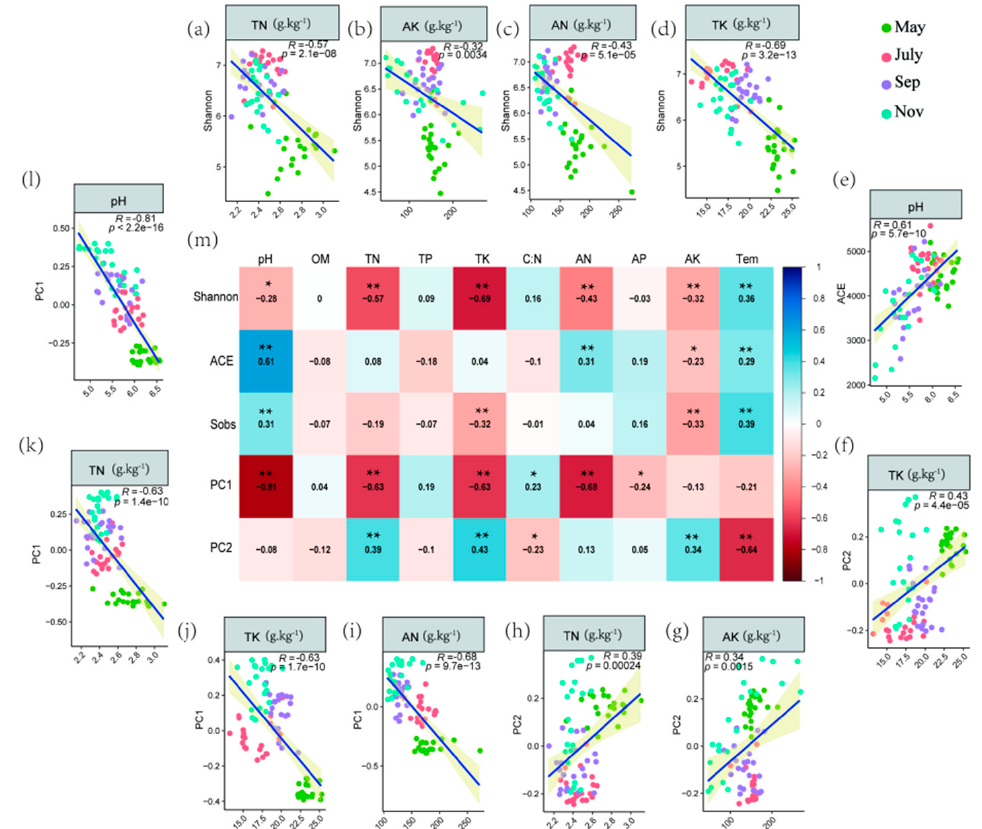
Figure 3. ( a – l ) Linear relationships among selected soil microbial properties and physicochemical variables. Their bivariate correlations were still significant after FDR adjustment ( p < 0.05). ( m ) Bi- variate correlations among important variables and soil physicochemical. The color indicates the direction of correlation, and the number represents the correlation coefficient, * p < 0.05, ** p <